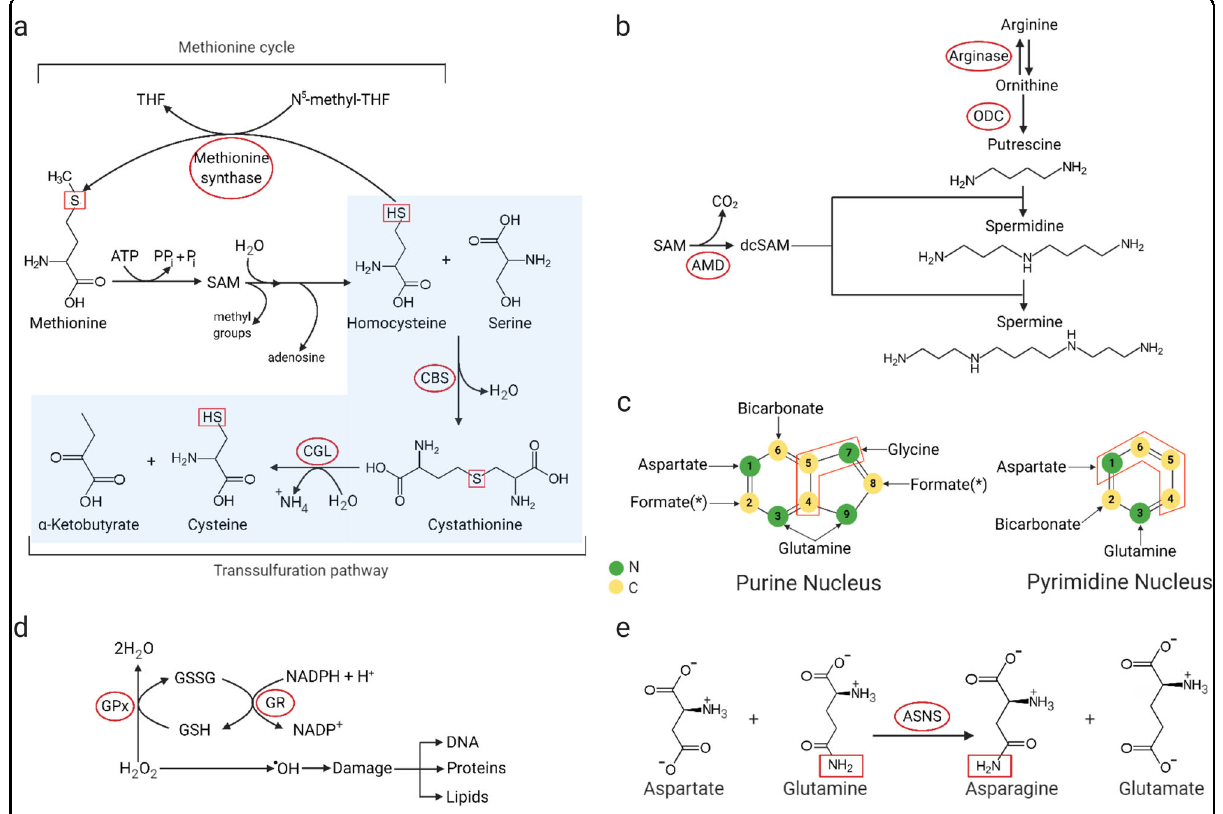
Fig. 2 Biochemical reactions in amino acid metabolism. a Reverse-transsulfuration pathway: Cysteine can be produced from methionine through the reverse-transsulfuration pathway. This pathway is a combination of the methionine cycle and transsulfuration pathway. Homocysteine, the intermediate of the fi rst step in the transsulfuration pathway, is generated from the methionine cycle. Serine condenses with homocysteine, producing cystathionine. Cystathionine is then converted to cysteine and alpha-ketobutyrate by CGL. Key enzymes are in red circle. THF tetrahydrofolate, CBS cystathionine β -synthase, SAM S-adenosylmethionine, CGL cystathionine γ -lyase. b Polyamine synthesis: Polyamines (putrescine, spermine, and spermidine) are synthesized from the amino acid arginine, and are converted from one to another (in the order of putrescine to spermidine to spermine). SAM, as the precursor of dcSAM, is the major donor for constructing polyamine structures. Key enzymes are in red circle. ODC ornithine decarboxylase, AMD S-adenosylmethionine decarboxylase, SAM S-adenosylmethionine, dcSAM decarboxylated S- adenosylmethionine. c Nitrogen and carbon source for nucleic acids: Aspartate, glycine, and glutamine provide nitrogen, and glycine and one- carbon units from the folate cycle (as a form of formate) provide carbon for purines. Glycine is formate ’ s indirect precursor through one-carbon metabolism, providing formate for biochemical reactions in purine biosynthesis. Aspartate and glutamine are the main amino acids involved in pyrimidine synthesis. Carbon (C) is in yellow, and nitrogen (N) is in green. d GSH and NADPH as antioxidants: Reactive oxygen species (ROS) bind and damage cellular macromolecules. The oxidation of NADPH and GSH allows ROS to be reduced to an inactive state. GSH reduces hydrogen peroxide to water and becomes oxidized to GSSG by GPX. Oxidized glutathione (GSSG) is then reduced back to GSH by GR in the presence of NADPH. Enzymes are shown in red circles. GPX glutathione peroxidase, GR glutathione reductase, GSH reduced glutathione, GSSG oxidized glutathione, NADPH reduced nicotinamide adenine dinucleotide phosphate, NADP + oxidized nicotinamide adenine dinucleotide phosphate. e Amidation reaction for asparagine synthesis: Asparagine is synthesized by an amidotransferase reaction, catalyzed by asparagine synthetase (ASNS). The conserved amide group nitrogen is in a red box, while the enzyme is in a red